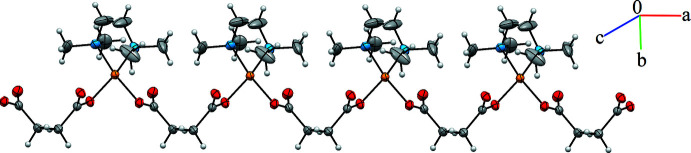
Ellipsoid plot (50%) of a section of the polymeric chain of {[Cu(succ)(tmeda)]·4H2O}n.